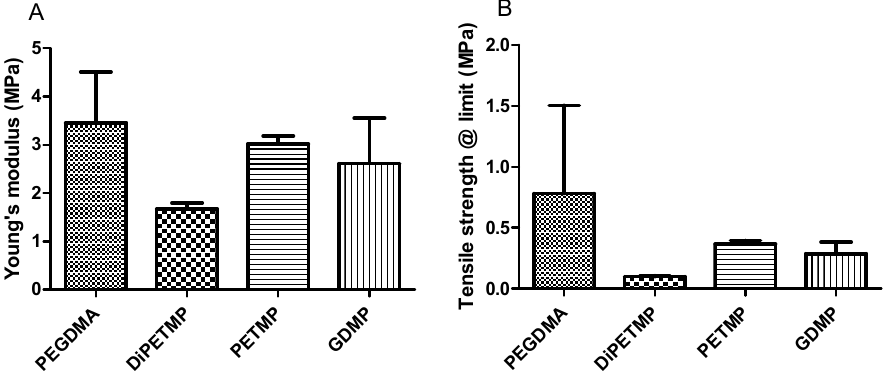
Figure 9. The dynamic mechanical analysis of the PEGDMA and PEGDMA-thiol samples post polymerization showing ( A ) Young’s Modulus and ( B ) the tensile strength at limit.